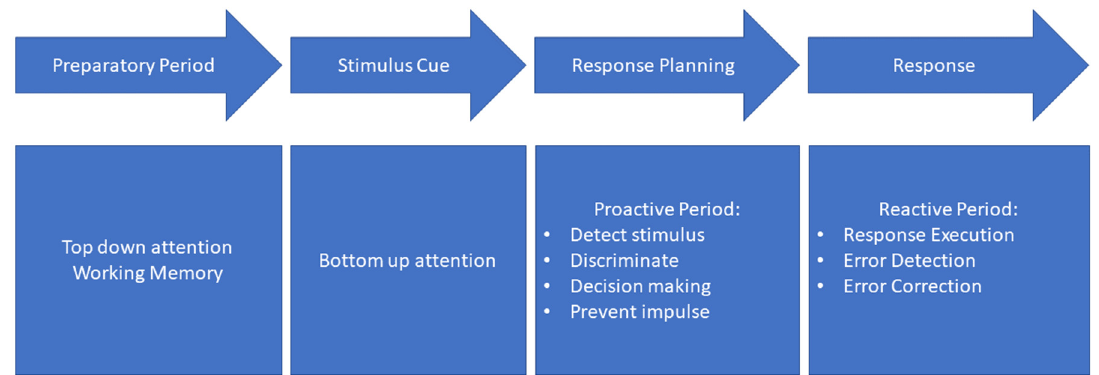
Figure 1. Go/No-Go underlying